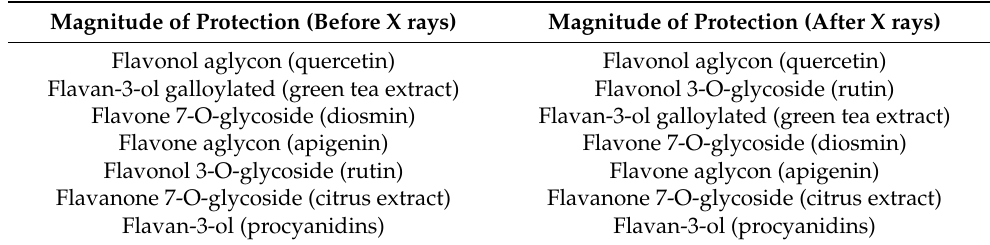
Table 2. Modifications in the chemical structure of the flavonoids tested from lower to higher genoprotective capacity, including the most significant structures of the extracts used in this